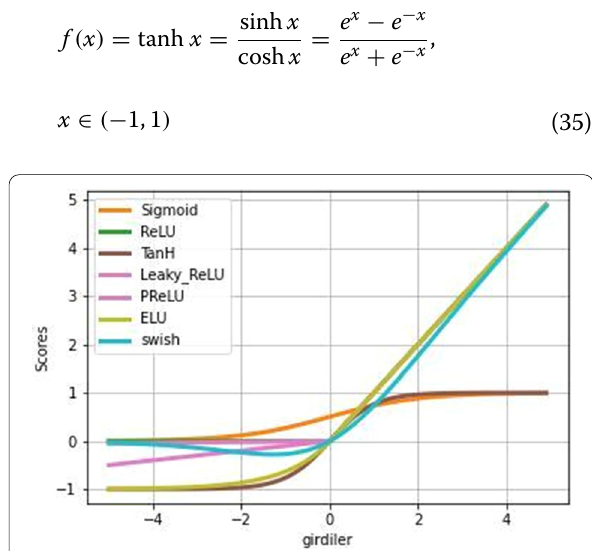
Figure 5 Different activation